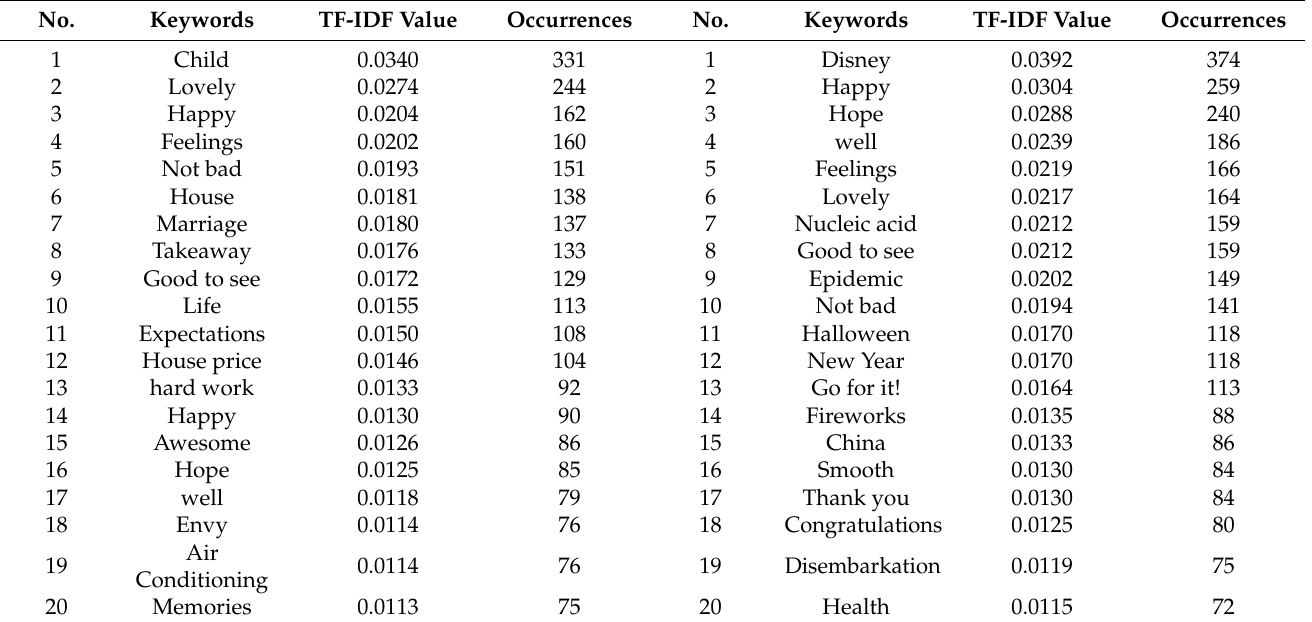
Table 5. Top 20 ranked keywords for B3 and